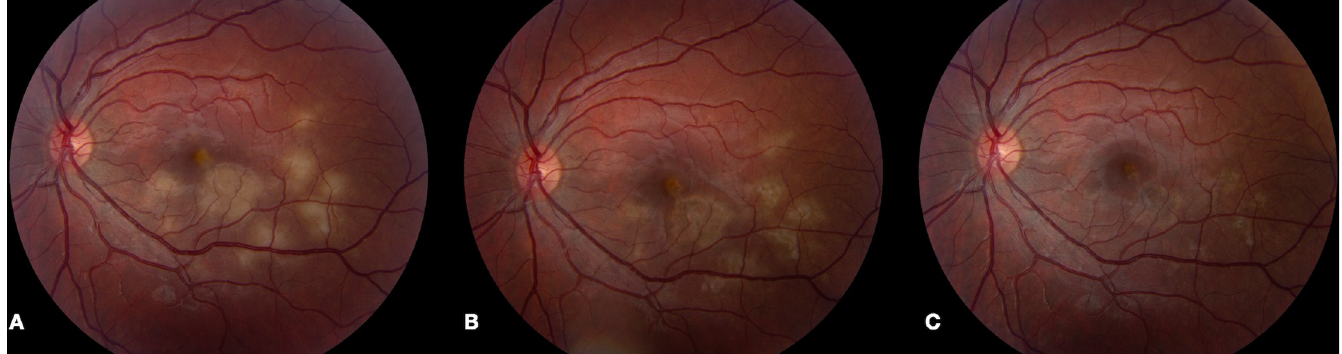
Fig 1. Fundus changes in APMPPE during active and inactive stages of disease. (A) Fundus photo of the left eye of patient 5 demonstrates multiple cream-colored placoid parafoveal lesions indicative of active disease. (B) Five days after treatment with high-dose prednisone, the lesions decreased in size with the interval development of overlying RPE hyperpigmentation. (C) One month later, fundus photo of the left eye revealed RPE pigmentary changes with complete resolution of the previously noted cream-colored lesions.